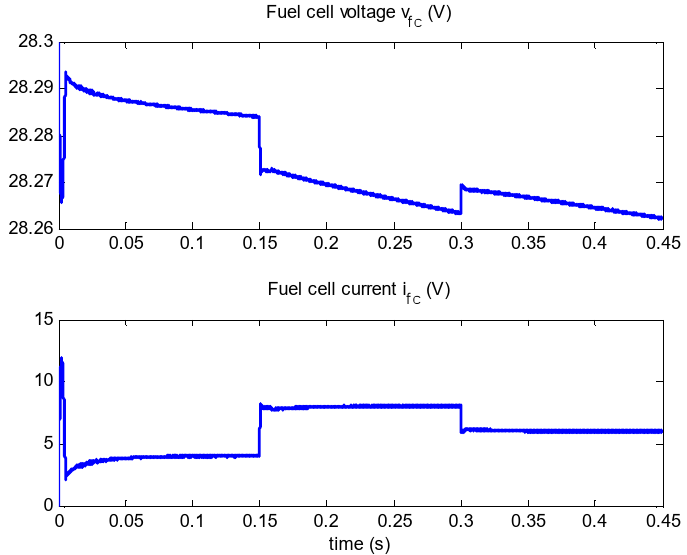
Figure 15. Fuel cell voltage and current in the presence of a time-varying reference. (B) Controller sensitivity to the perturbation caused by load uncertainty.